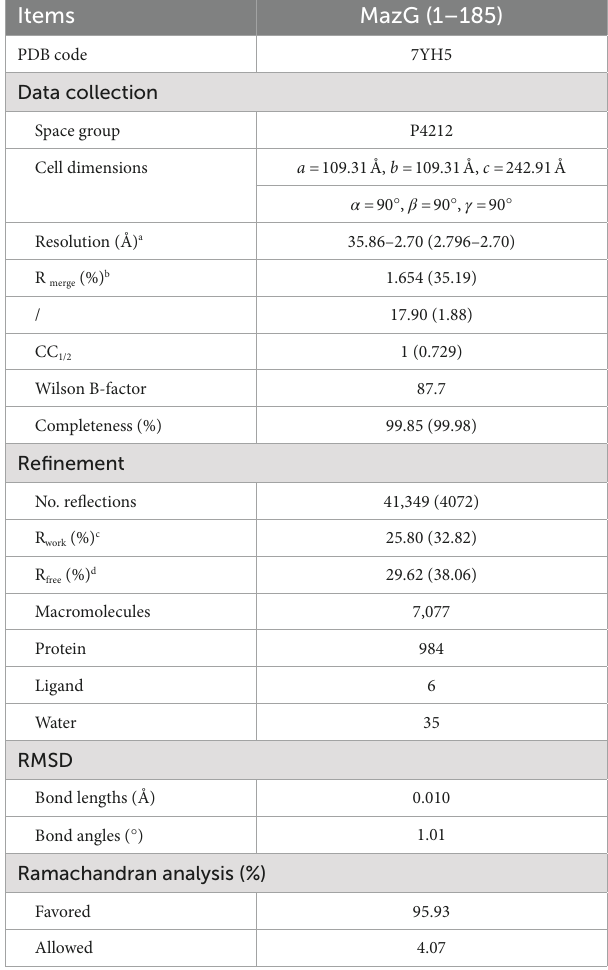
TABLE 1 Data collection and refinement